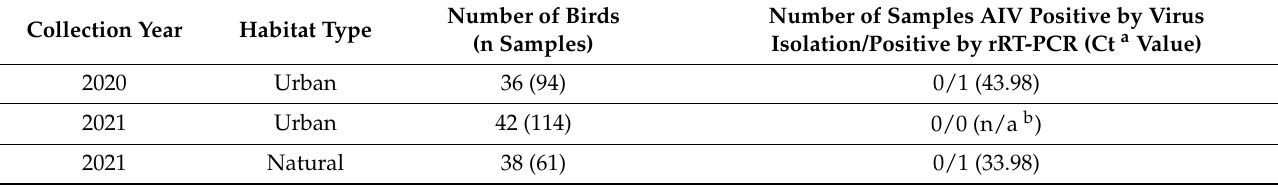
Table 1. Total swab samples collected for avian influenza virus (AIV) isolation and real-time reverse transcriptase- polymerase chain reaction (rRT-PCR) screening from ibis nestlings in urban rookeries in 2020 and urban and natural rookeries in 2021. Nestlings were sampled weekly from hatch until approximately 3 weeks of